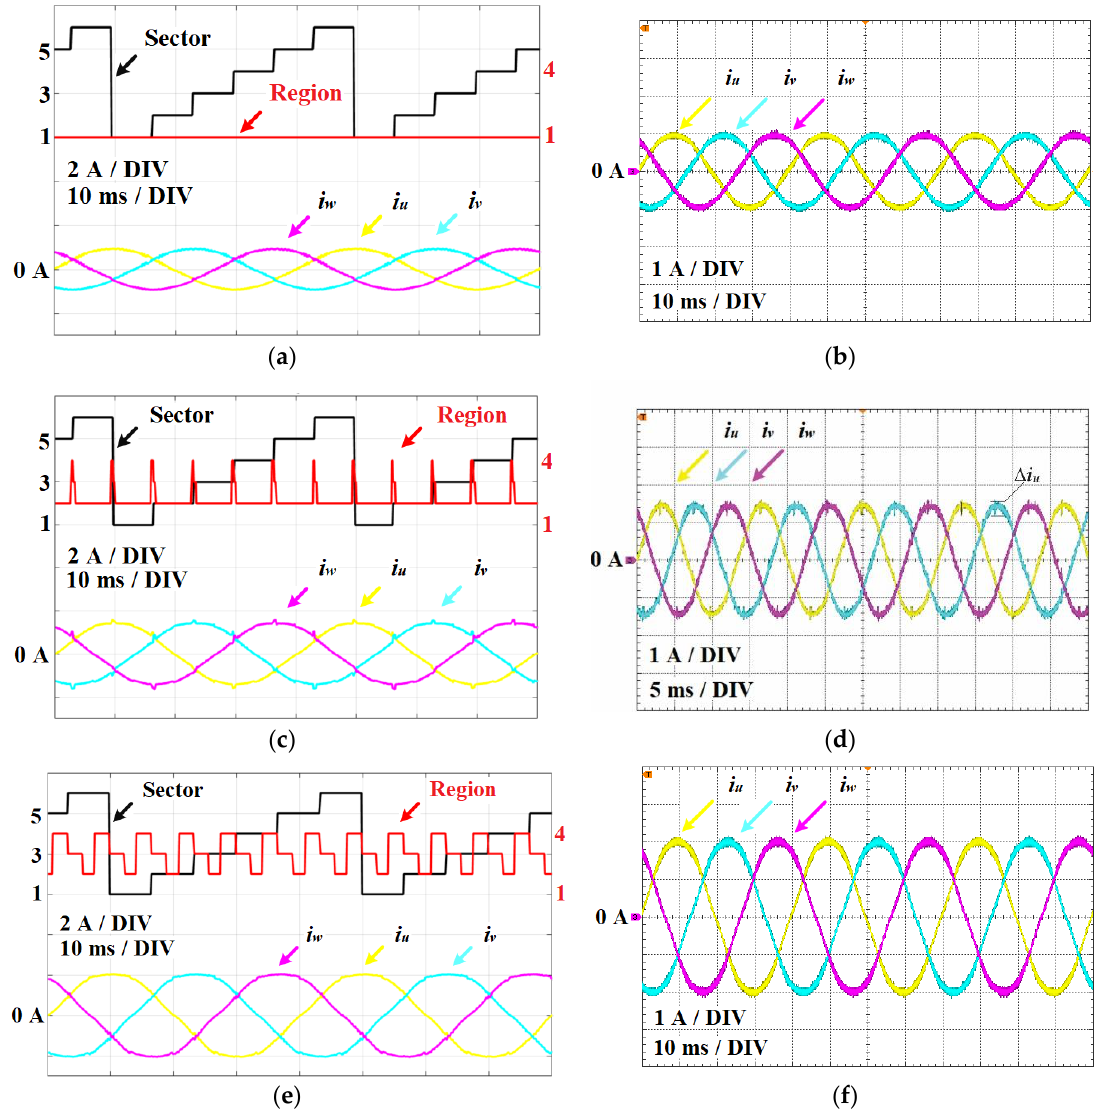
Figure 18. Single-shunt reconstruction of a three-phase current with SVM modification for f = 25 Hz: ( a ) m i = 0.4; ( c ) m i = 0.6; ( e ) m i = 0.8; scope-measured real three-phase currents for f = 25 Hz: ( b ) m i = 0.4; ( d ) m i = 0.6; ( f ) m i = 0.8.